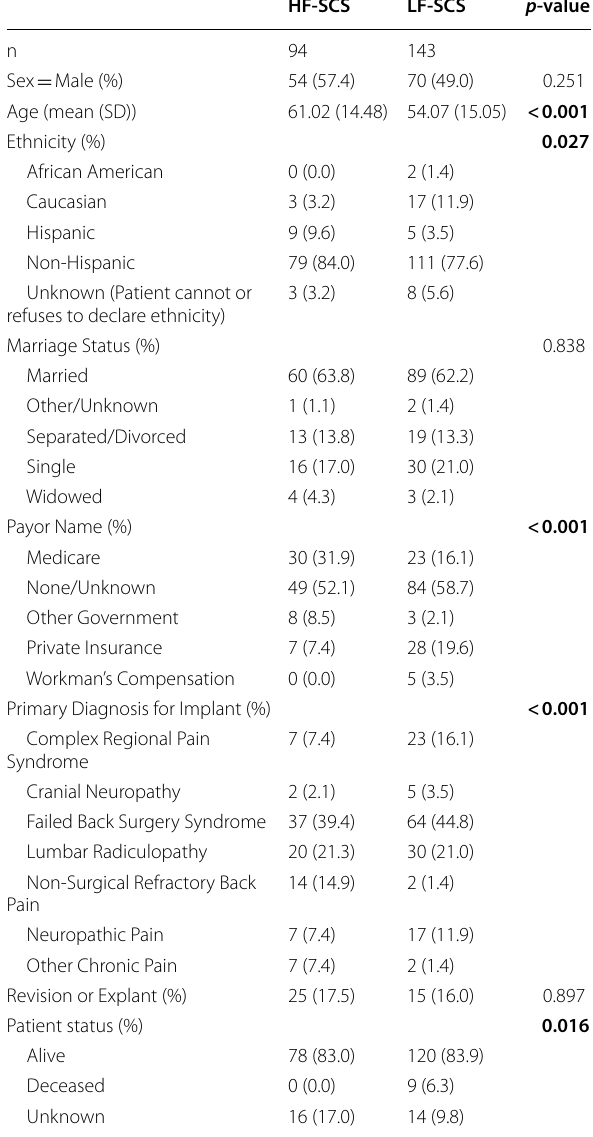
Table 1 Patient characteristics by type of